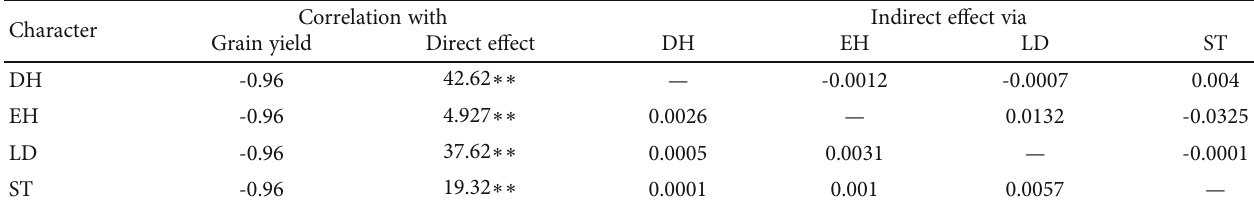
Table 6: Direct and indirect e ff ects of B. fusca damage traits on total grain yield at Embu site. Character